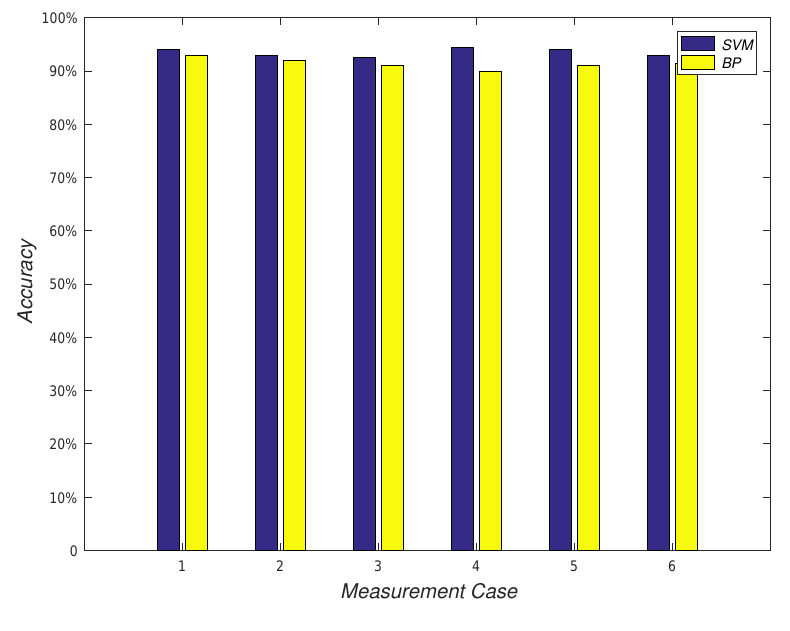
Figure 6. Accuracy of base